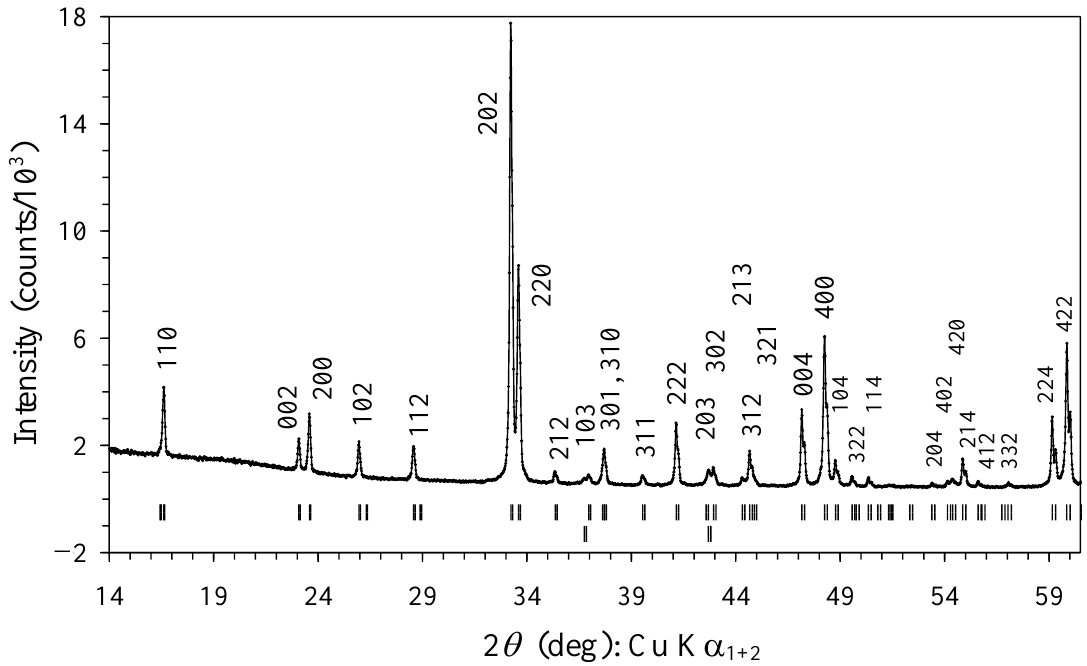
Figure 2. Laboratory powder X-ray diffraction pattern of Sm 2 CuMn(MnTi 3 )O 12 in a 2 θ range from 14 ◦ to 60.5 ◦ . Possible Bragg reflection positions for Sm 2 CuMn(MnTi 3 )O 12 (the first row) and CuO impurities (the second row) are shown. The ( hkl ) indices of all of the observed reflections of Sm 2 CuMn(MnTi 3 )O 12 are given.